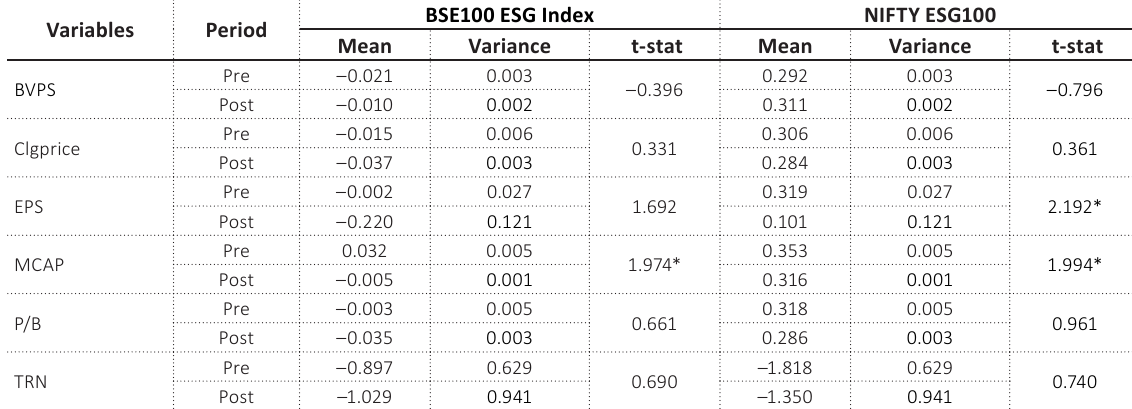
Table 3. Firm performance during the pre-and post-inclusion period of the BSE100 ESG Index and NIFTY ESG100